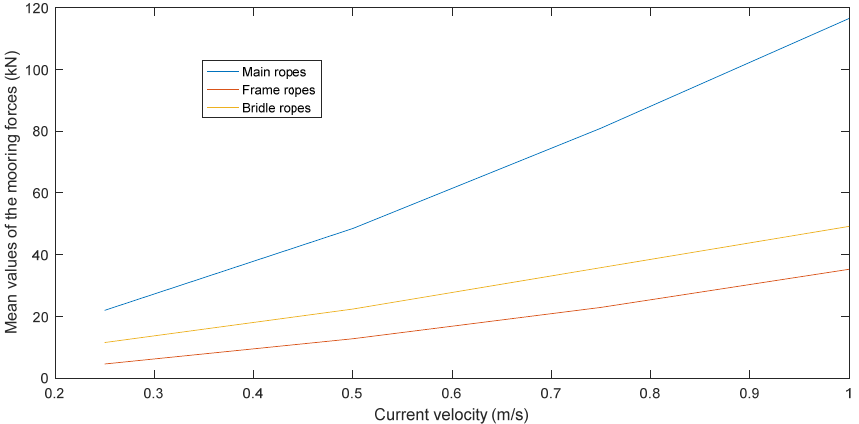
Figure 9. Mean values of the maximum mooring forces under different current velocities.